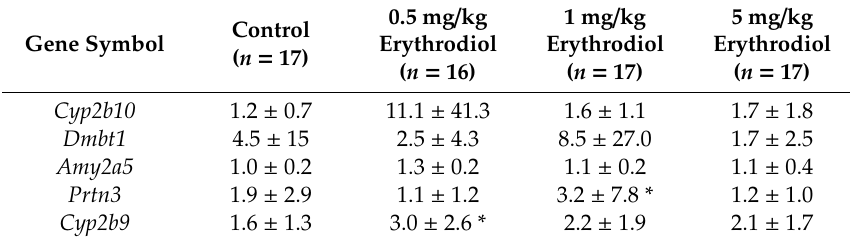
Table 5. Hepatic changes in selected gene expressions of male Apoe -deficient mice receiving di ff erent doses of